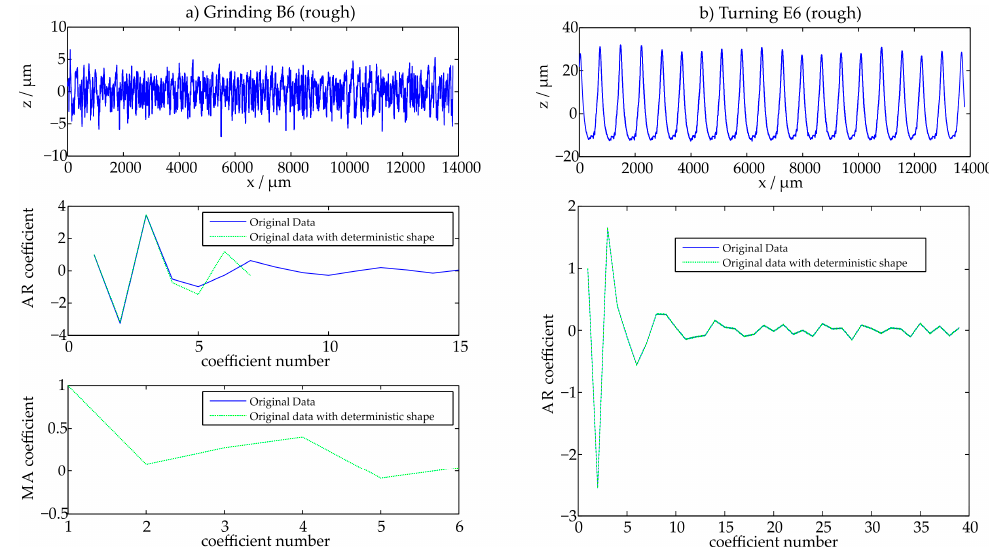
Figure 6. Coefficient comparison, original data and data with deterministic shape.